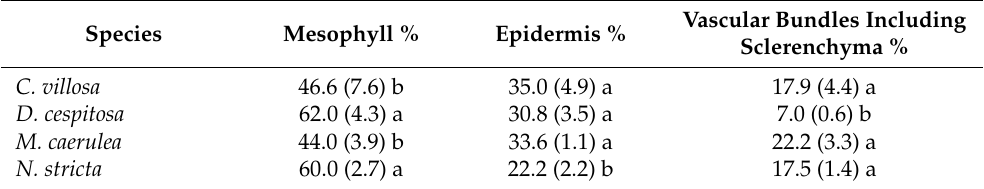
Table 2. The percentage of mesophyll, epidermis and vascular bundles including sclerenchyma on the leaf cross section. Mean and standard deviation (in brackets); different letters denote significant difference at α = 0.05 according to one-way ANOVA and Tukey–Kramer test. N = 6 for C. villosa , D. cespitosa , and N. stricta ; n = 5 for M. caerulea